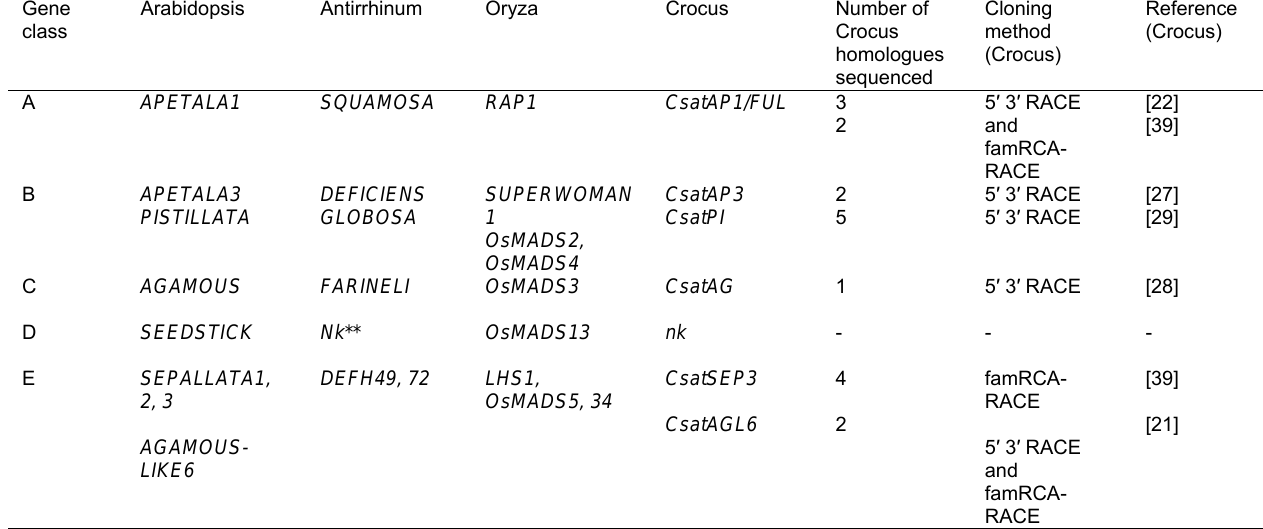
Homologues of the Major A, B, C, D, E Types of MADs-box Genes from Crocus, the Two Dicots Model Species Arabidopsis and Antirrhinum and the Monocot Model,